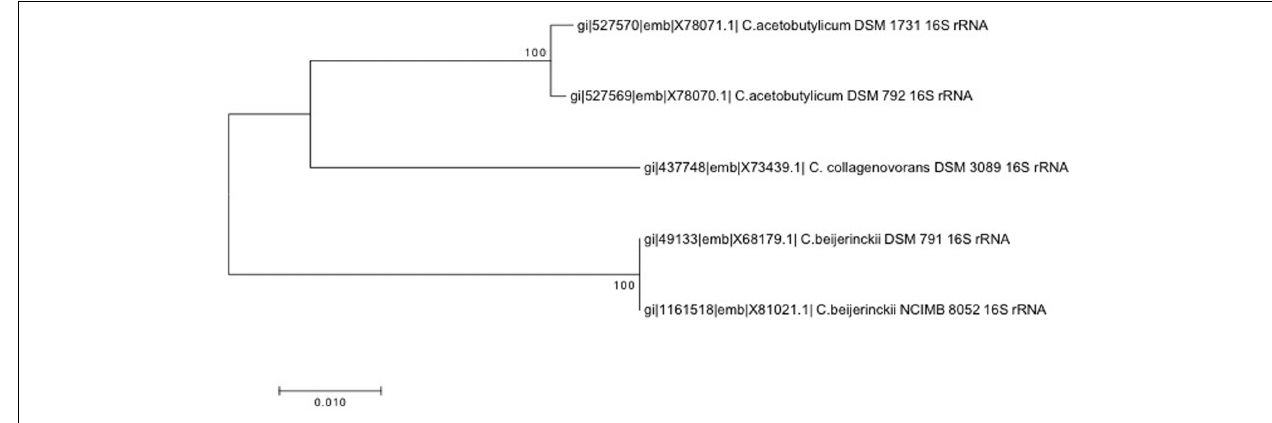
Bacterial Growth and Spore